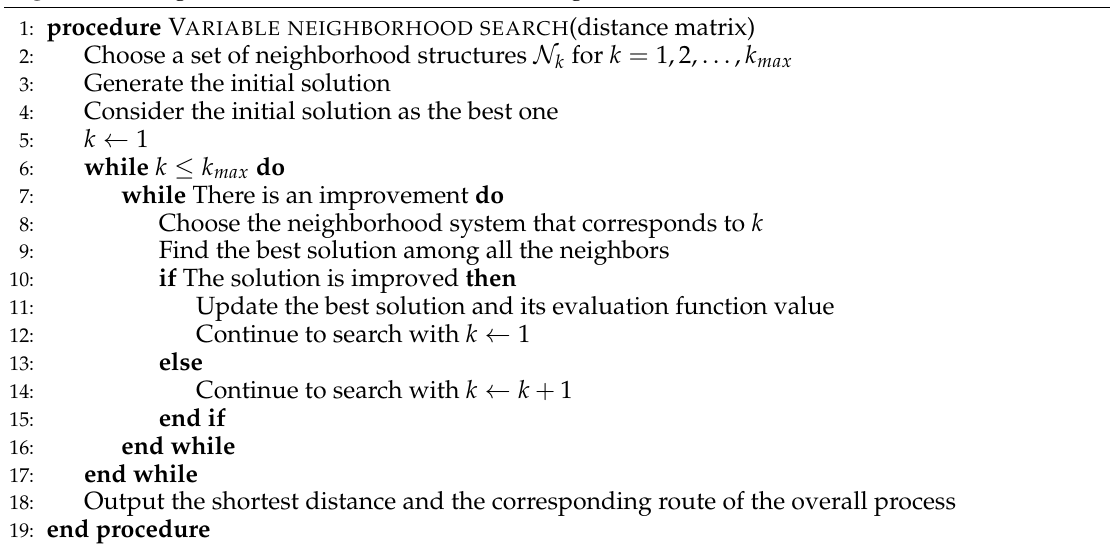
Algorithm 2 Algorithm to determine solutions using VNS.